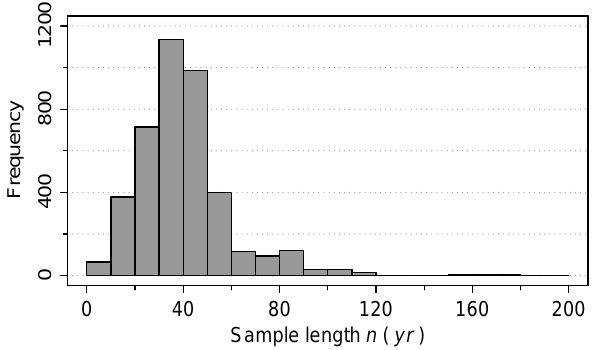
Figure 2. Sample length distribution for the entire FloodFreq